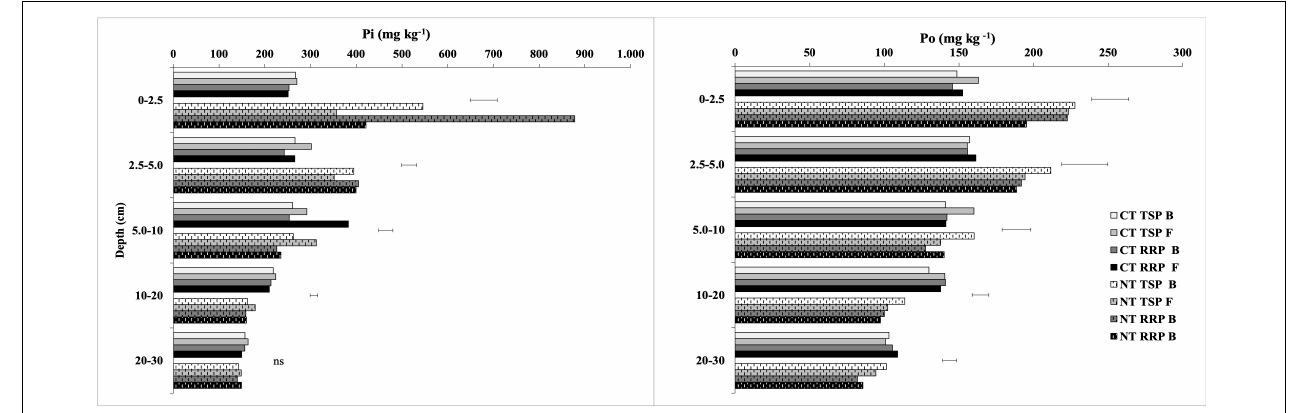
FIGURE 1 | Distribution of geochemical P (Pi) and biological P (Po) in five layers of a very clayey Oxisol after 17 years of cultivation in different soil tillage systems and phosphate fertilizer sources and application methods. CT, conventional tillage; NT, no-tillage; TSP, triple superphosphate; RRP, reactive rock phosphate; B, broadcast; F, furrow. The bars represent the LSD at 5% probability by Fischer’s